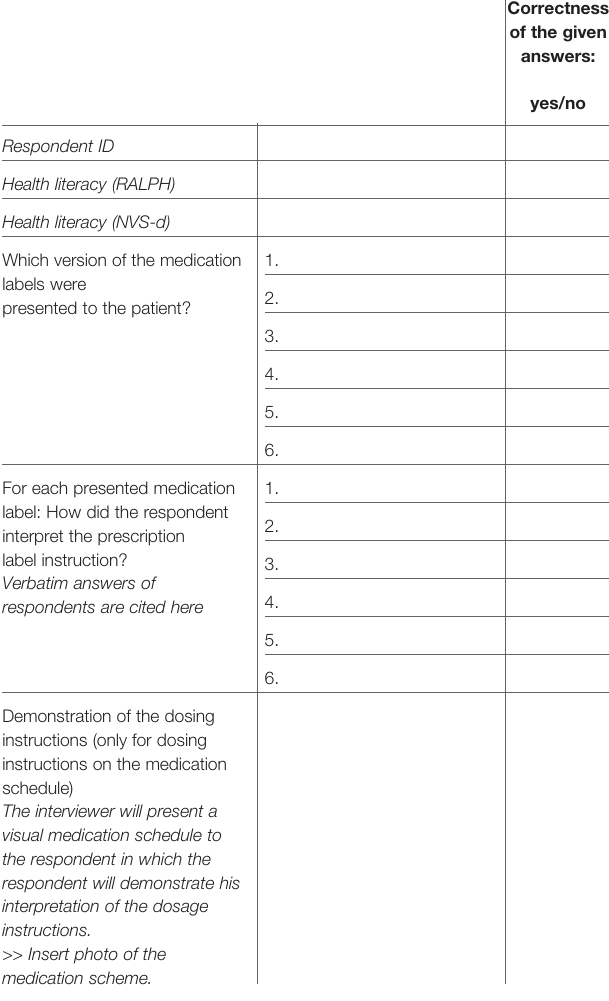
TABLE 3 | Coding scheme for the patient study in phase 2b.